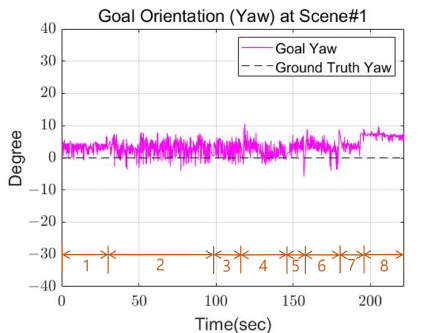
Figure 15. The goal orientation of Scene